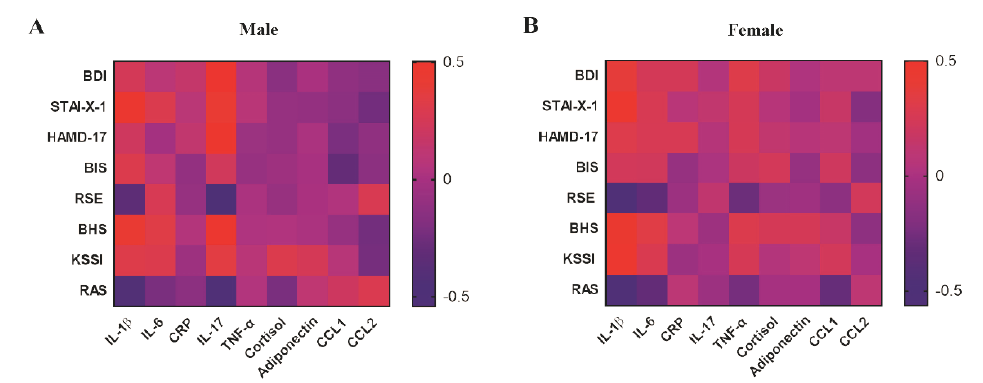
Figure 3. The heatmap indicates the r -value of the correlation between the clinical scores and inflammatory biomarkers of participants in young adulthood. The red color means a positive correlation, and the blue color means a negative correlation in both male and female participants. ( A ) Male (HC, n = 24; MDD, n = 23) and ( B ) female (HC, n = 26; MDD, n = 27).